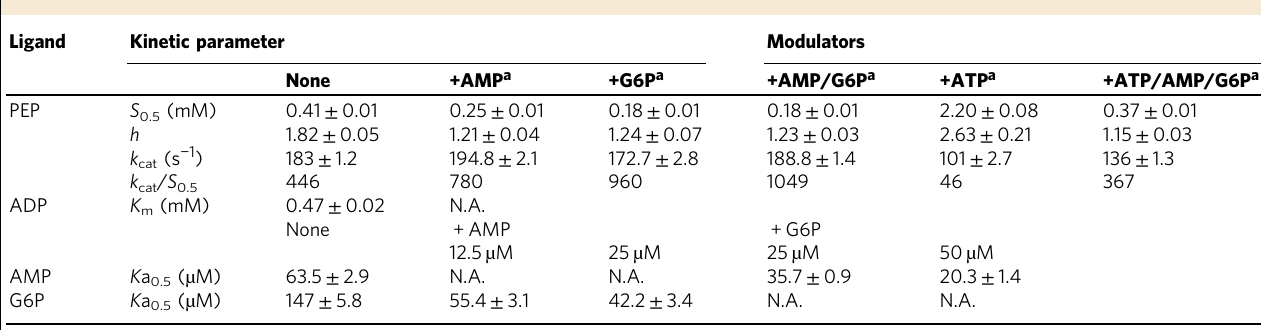
Table 1 Kinetic properties of Mtb PYK